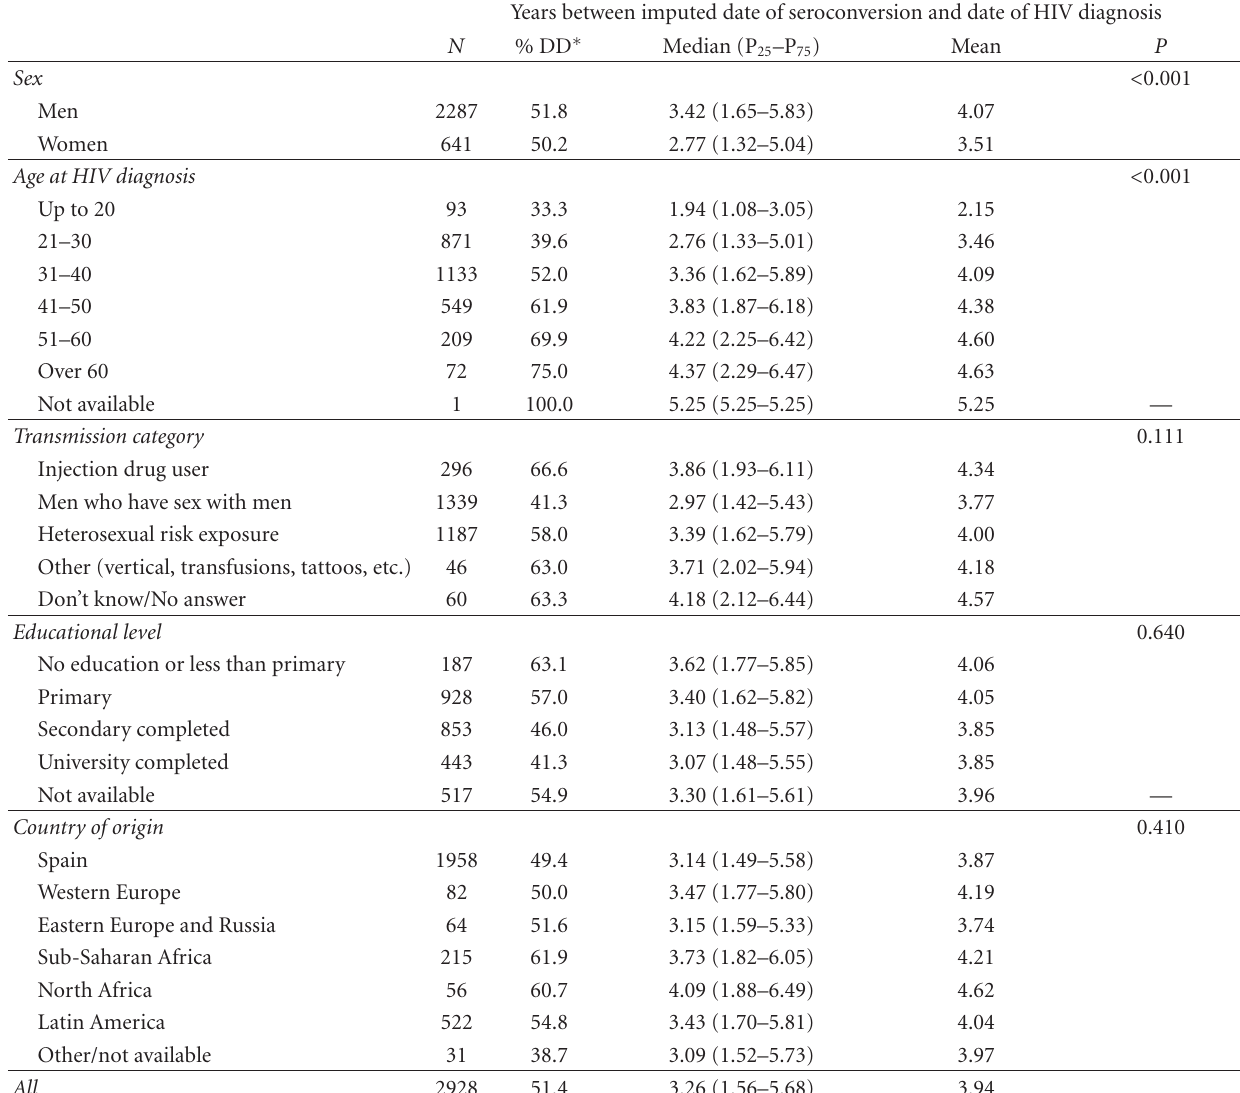
Table 3: Years between the imputed date of seroconversion and the date of HIV diagnosis. Results in the subcohort of new diagnoses ( n =